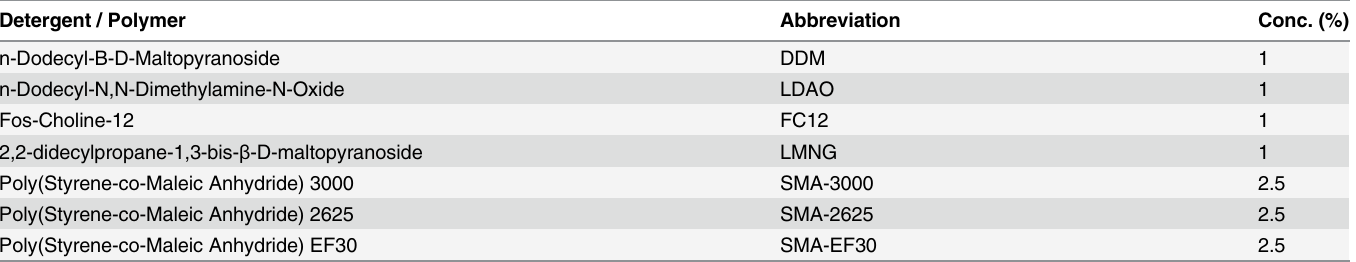
Table 3. Detergents and hydrolyzed forms of SMA polymers used in screening for solubilization efficiency of membranes containing TSPAN-GFP fusion proteins. Listed are also the final concentration used for